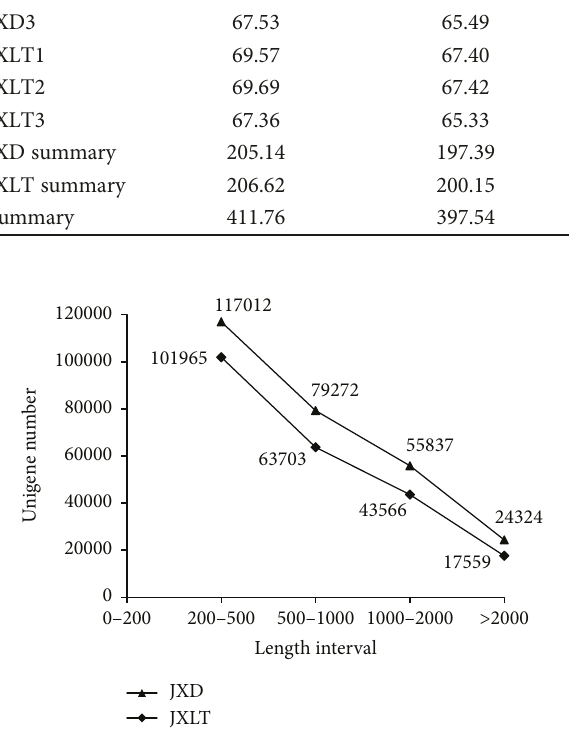
Figure 2: Quantitative distribution of Unigene length in JXD and